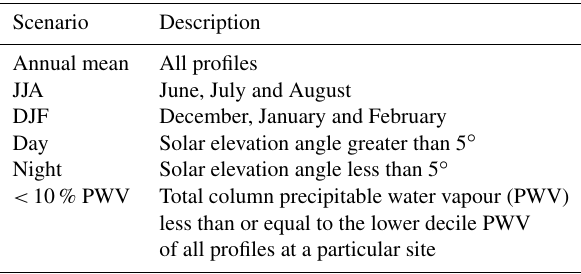
Table 2. The six scenarios constructed from all spliced radiosonde and ERA-Interim reanalysis profiles. All constituent profiles are close to local noontime.